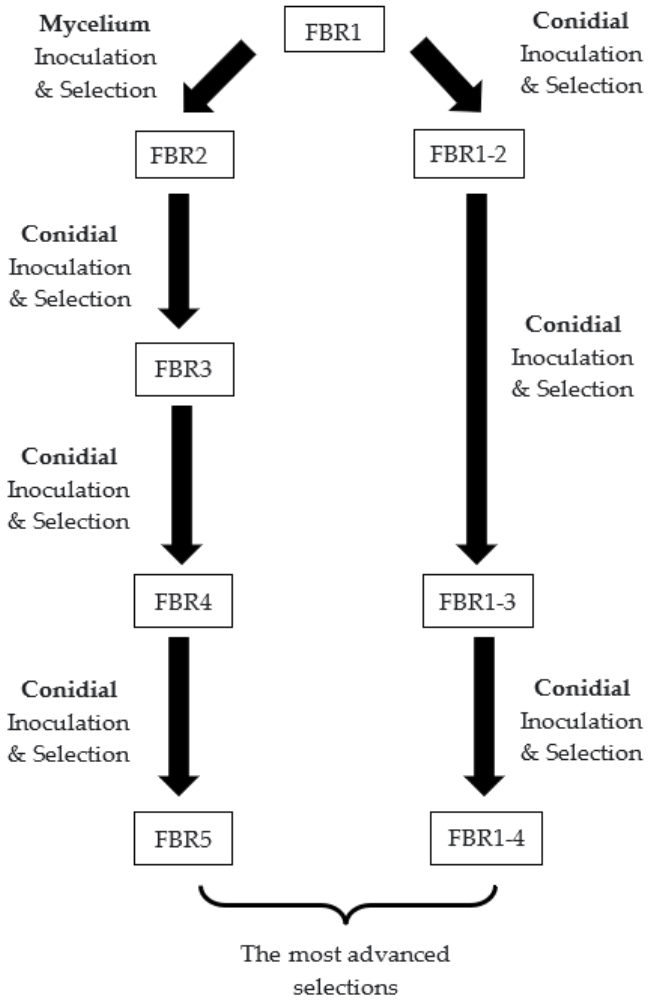
Figure 2. Selection scheme for development of cultivar populations using artificial inoculation mature bulb screening (AIMBS).